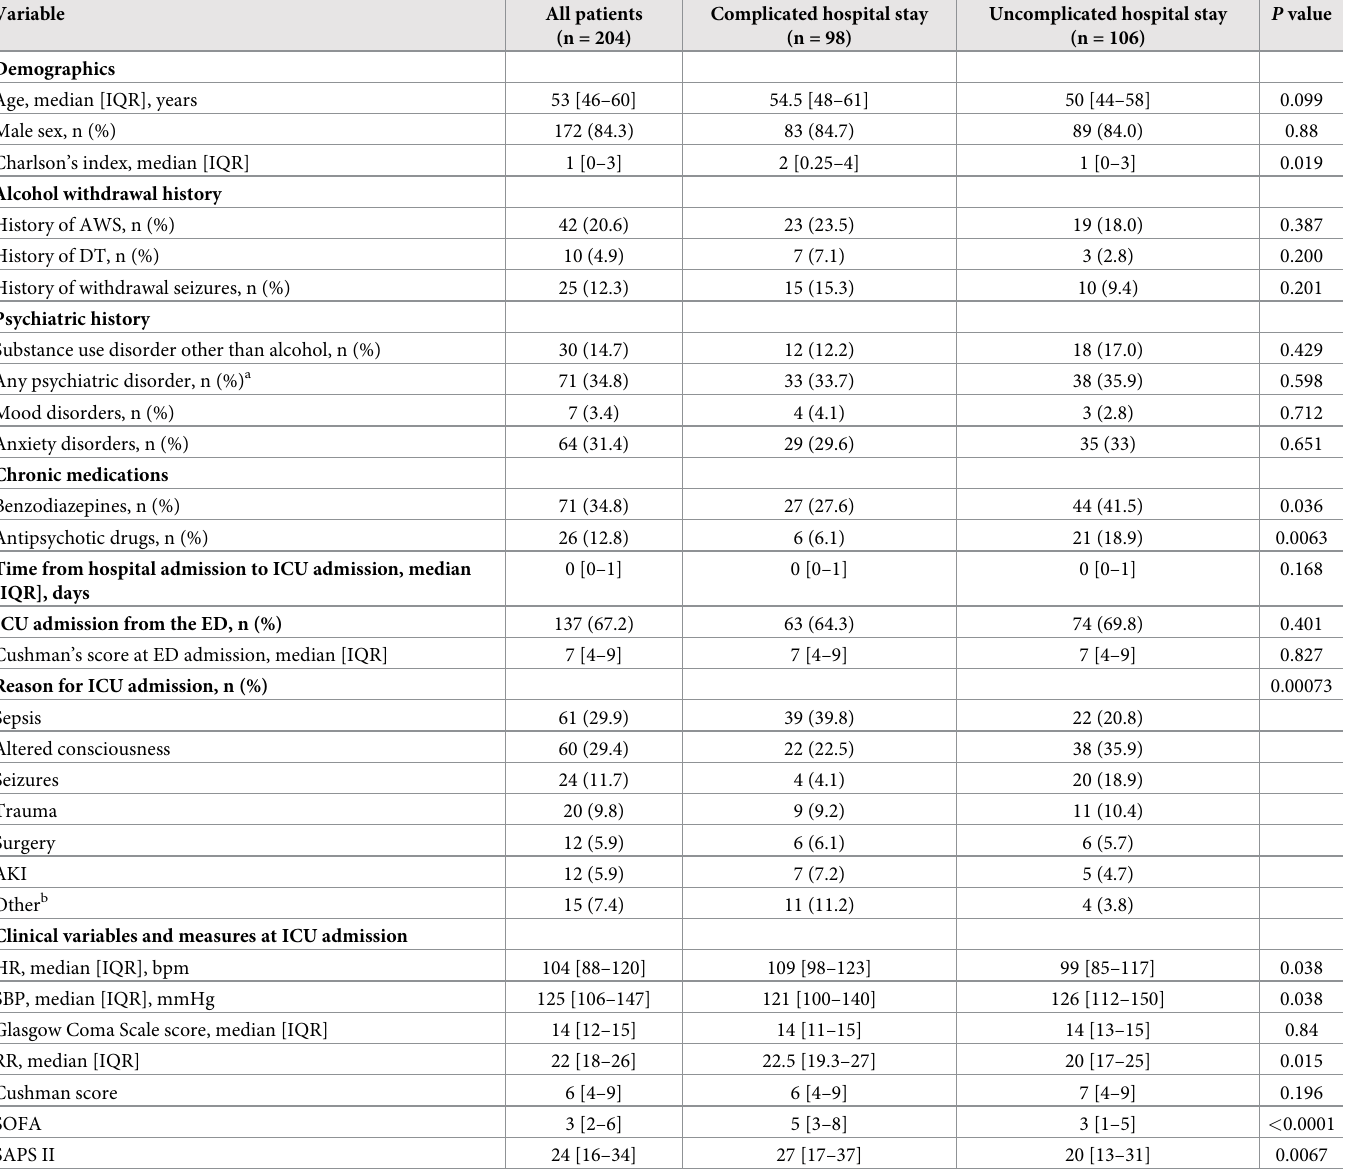
Table 1. Baseline characteristics of the 204 study